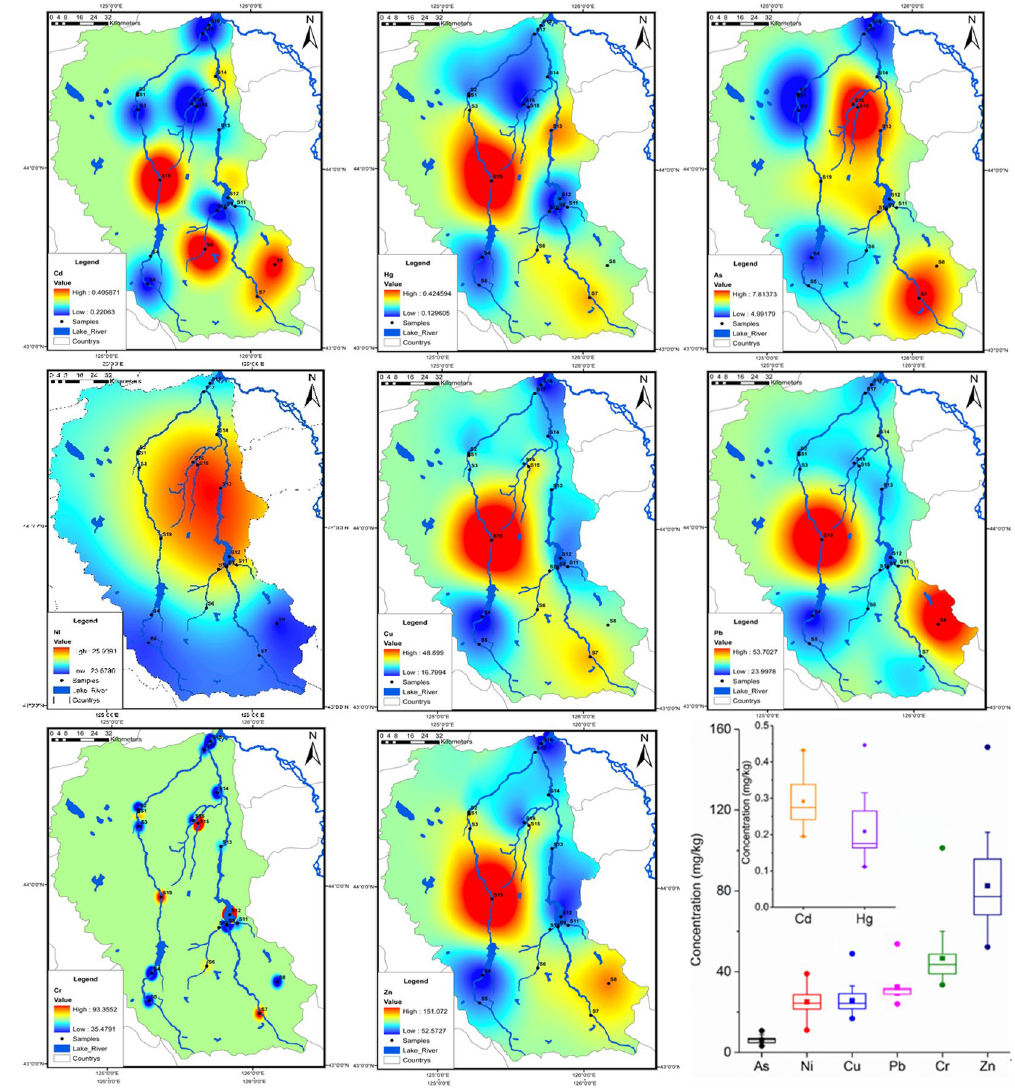
Figure 2. Spatial distribution of heavy metals in